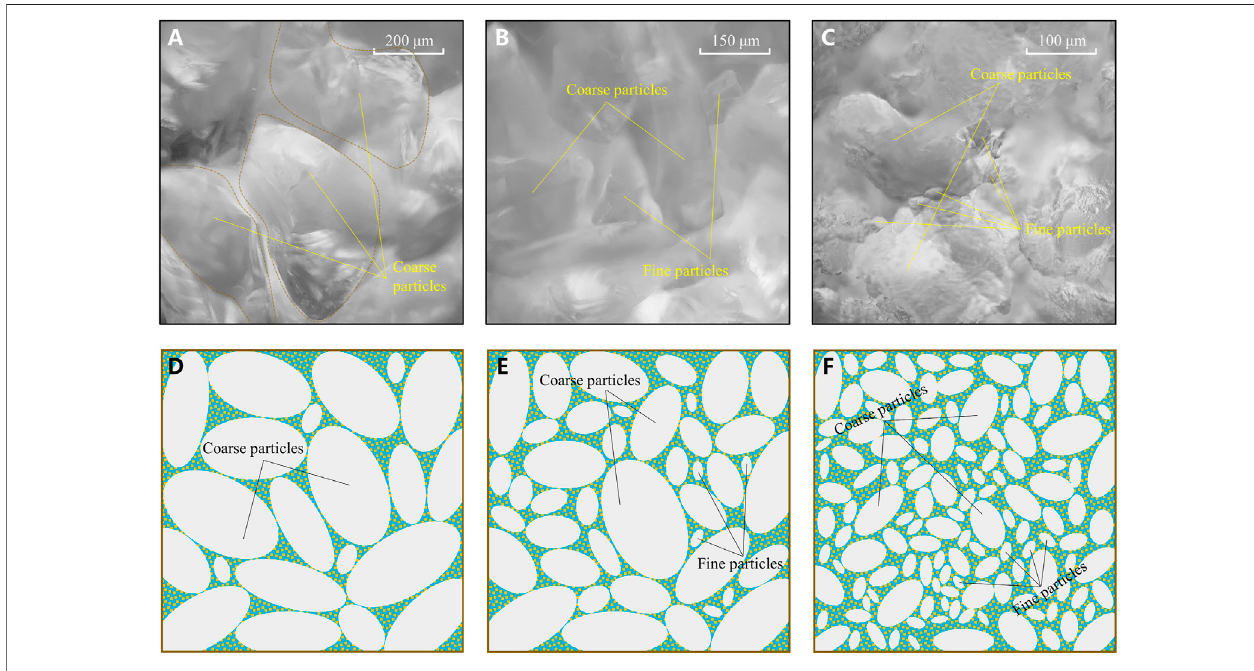
FIGURE 12 | Mesoscopic characteristics of TCS with different particle gradations of fused quartz: 0.5 – 2.0 mm in group G11 (A – D) , 0.2 – 2.0 mm in group G10 (B – E) and 0.2 – 1.0 mm in group G9 (C – F) .